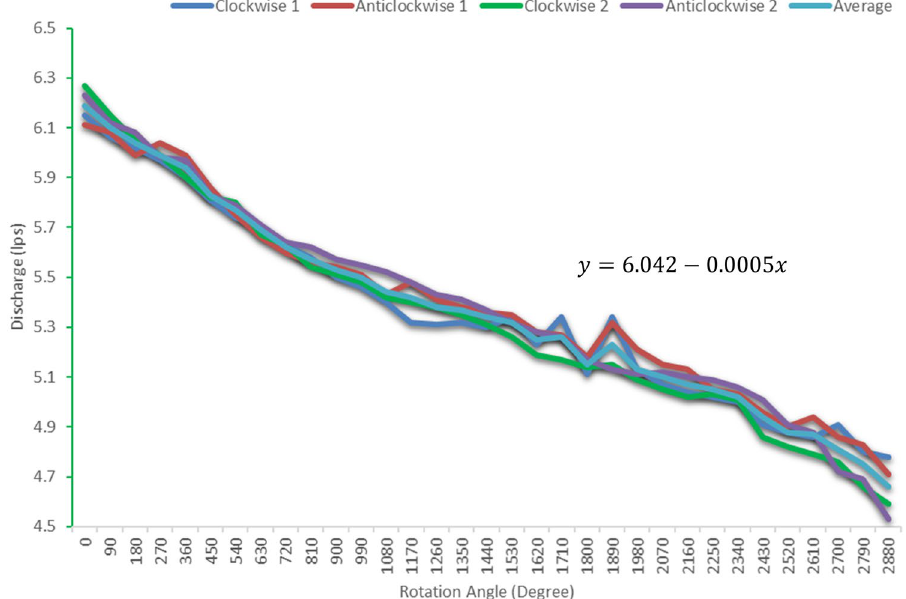
Fig. 6 Discharge through modified gate valve at an interval of 90° rotation angle in clockwise and anticlockwise